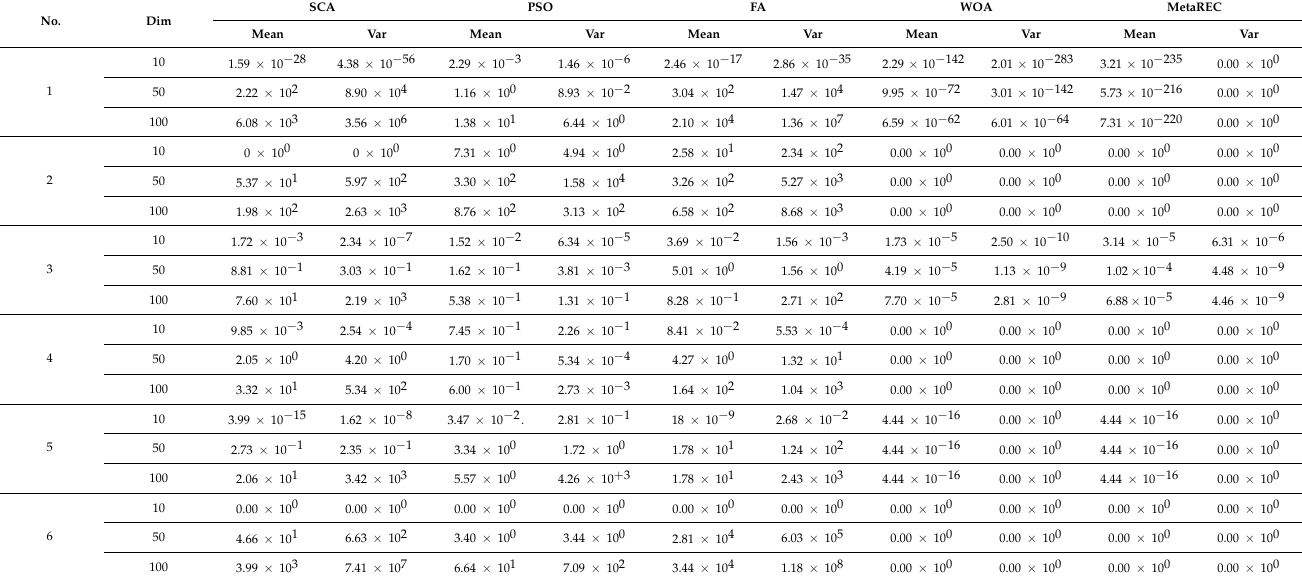
Table 3. Means and variances of the SCA, PSO, FA, WOA, and MetaREC on test